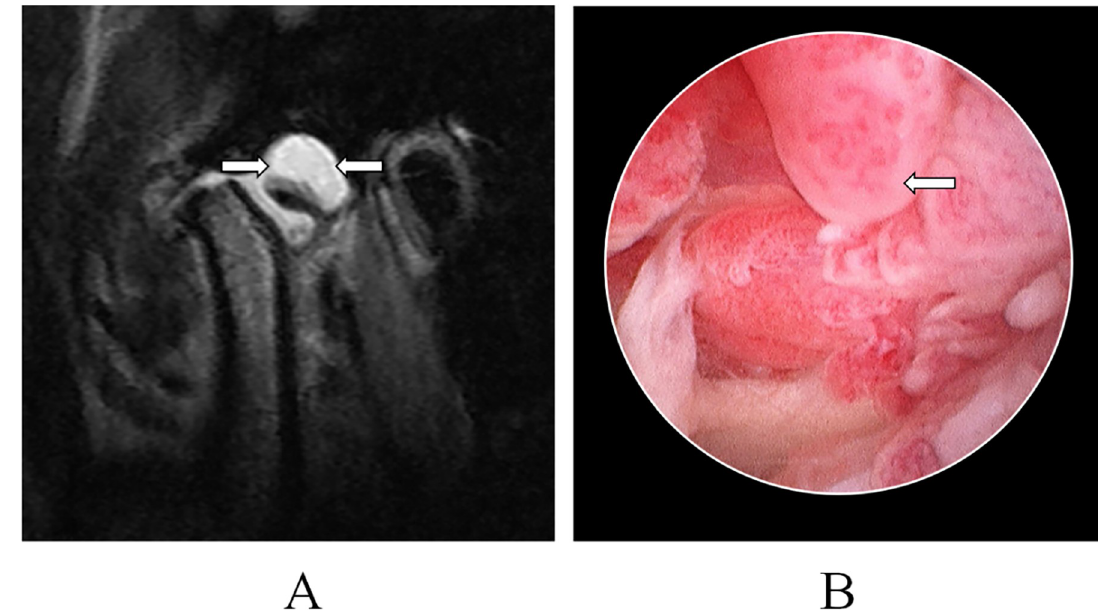
Fig 3. Synovitis of temporomandibular joint: hyperintense synovial fluid was uniformity and moderate signal mass (arrow) was observed on a T2 sequence of MRI, A; No loose body was detected during arthroscopic surgery, B.